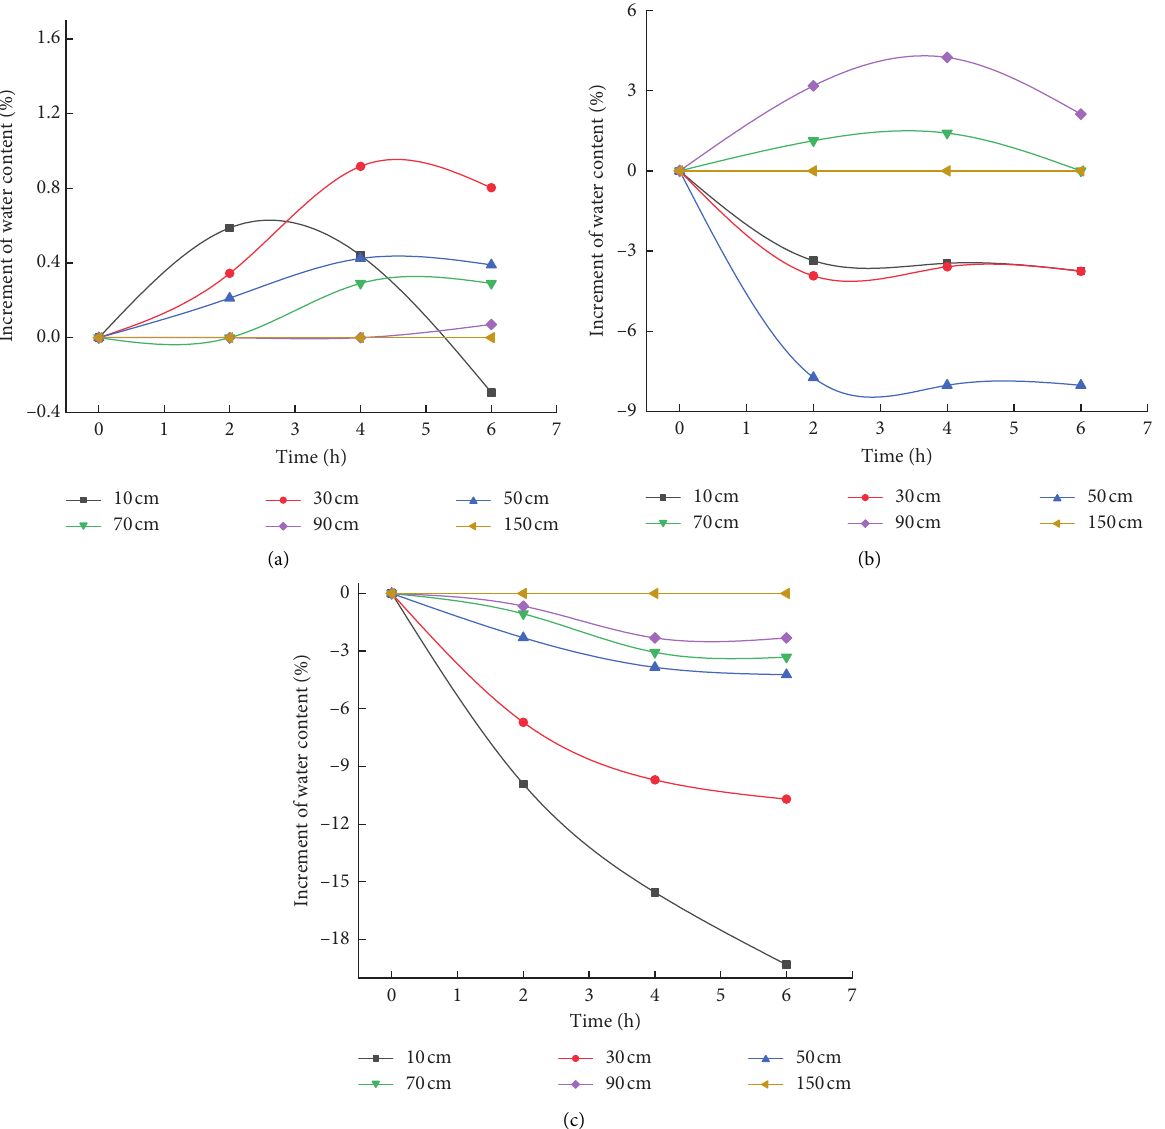
Figure 6: Relationship between water content of slope surface and time after rain: (a) August 30; (b) September 5; (c) September